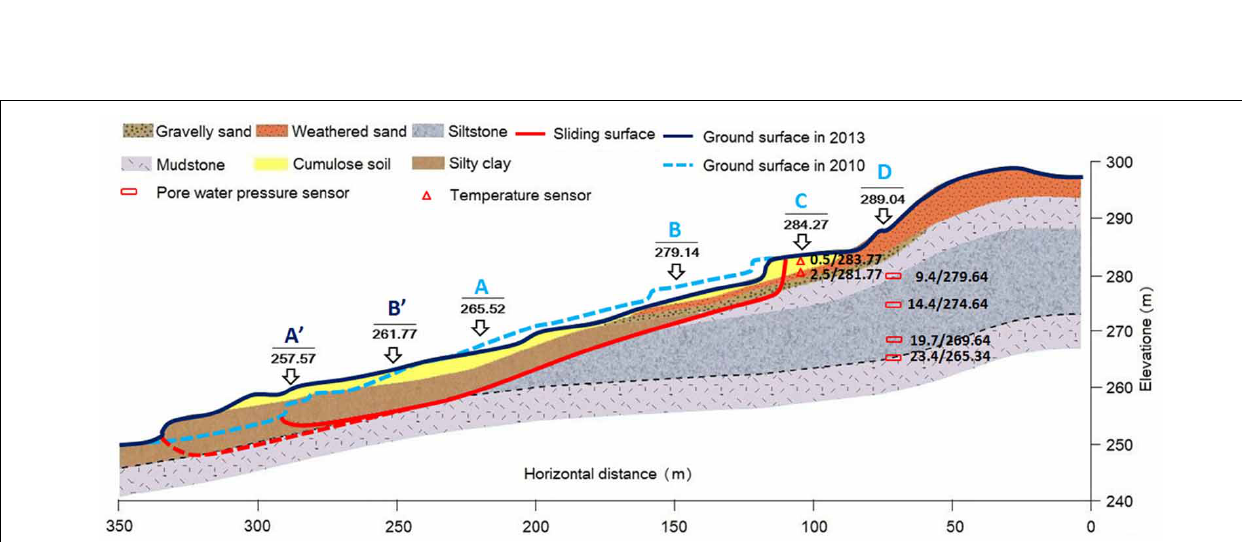
FIGURE 9 | The profiles of Landslide K178 + 530 along the sliding